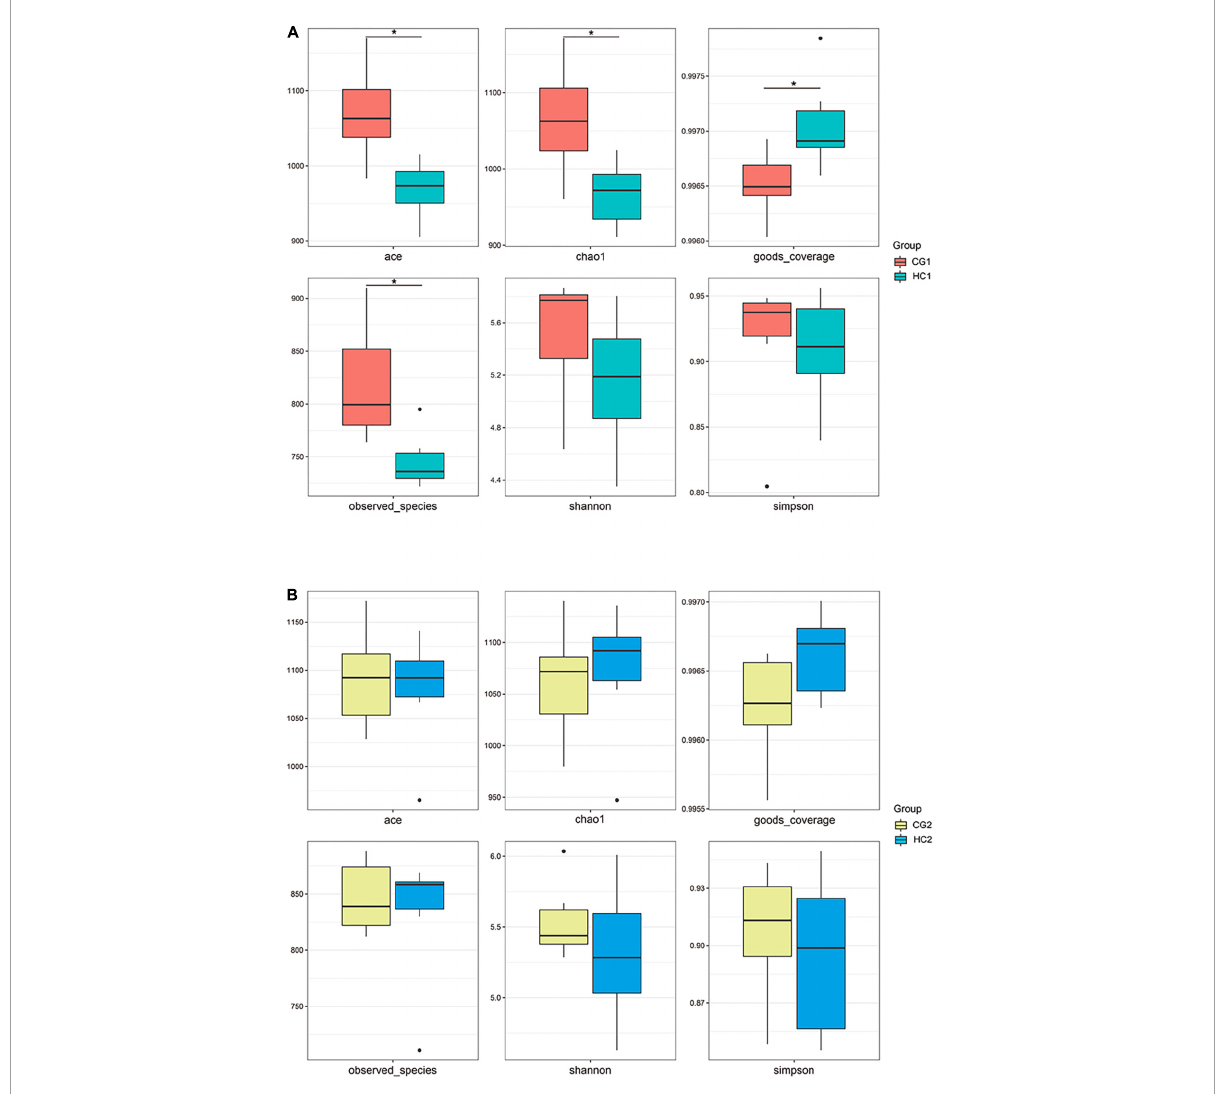
FIGURE1 Changes in Alpha diversity index of cecal microbiota after C. butyricum supplementation at 53 (A) and 67 (B) days of age. CG1, control group at 53 days of age; CG2, control group at 67 days of age; HC1, the high dose at 53 days of age; HC2, the high dose at 67 days of age. * P < 0.05, ** P < 0.01, *** P < 0.0001, and **** P < 0.0001.